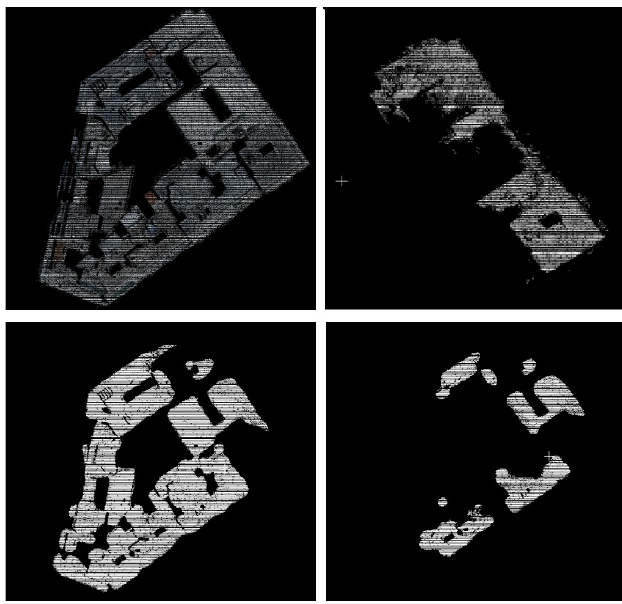
Figure 6: Total cloud (top left), first highest level (top right), rest cloud (bottom left) and second highest level (bottom